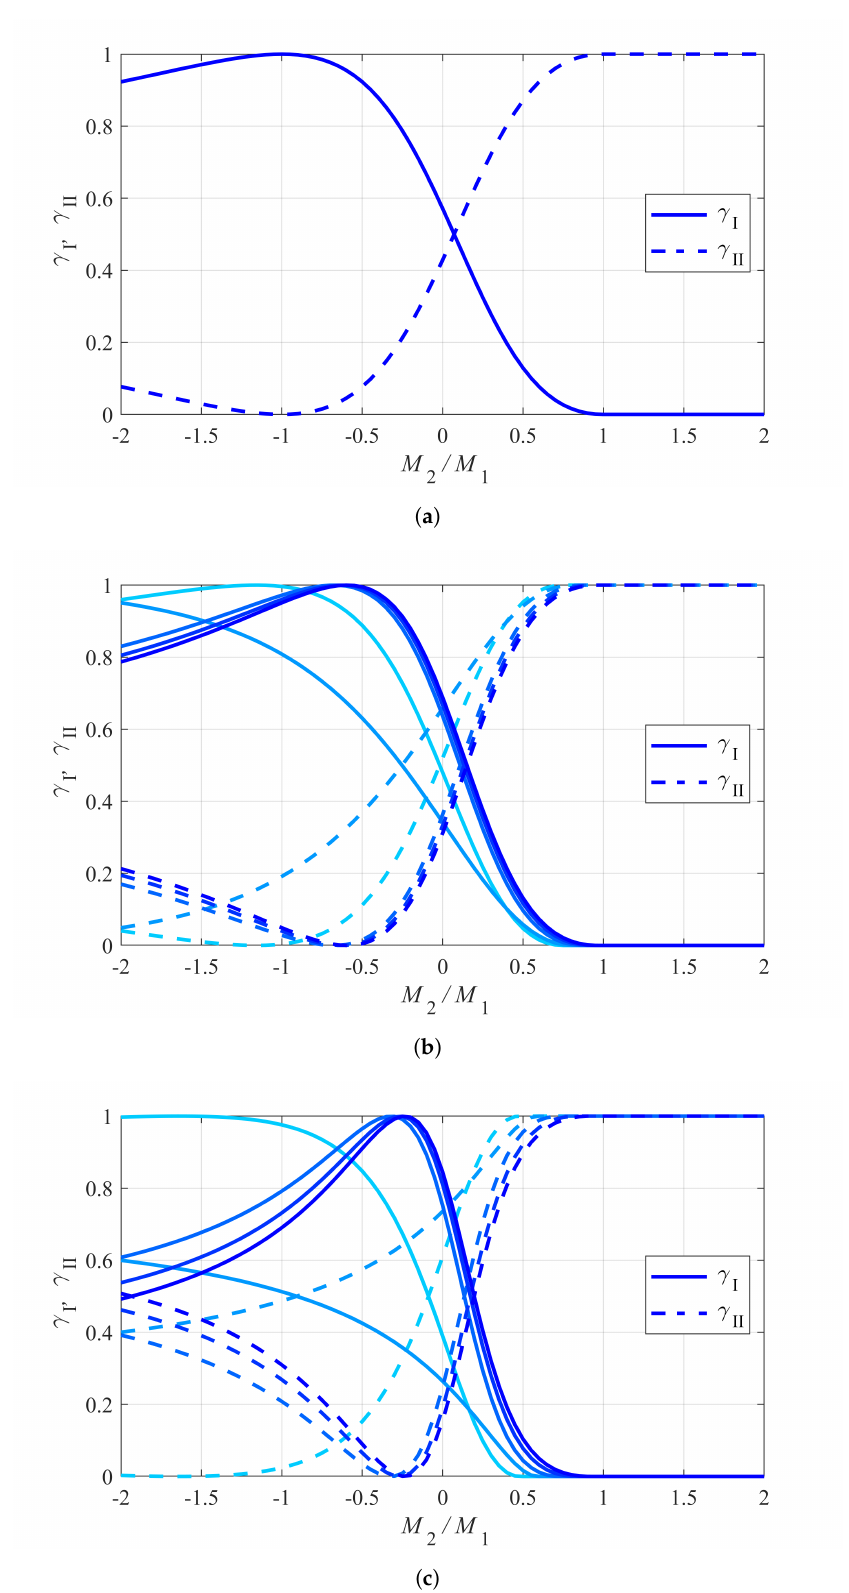
Figure 8. Dimensionless modal contributions to energy release rate vs. sublaminate bending moment ratio: ( a ) UD//UD specimen, ( b ) UD//CP specimen, and ( c ) UD//MD